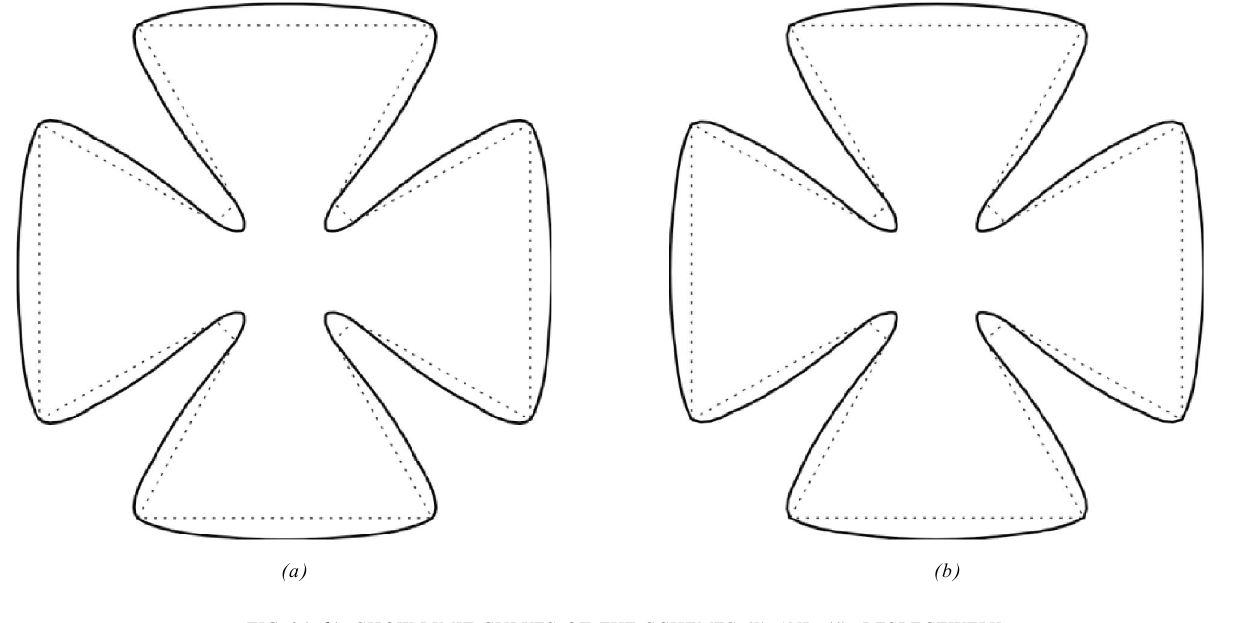
FIG. 3(a-b). SHOW LIMIT CURVES OF THE SCHEMES (5) AND